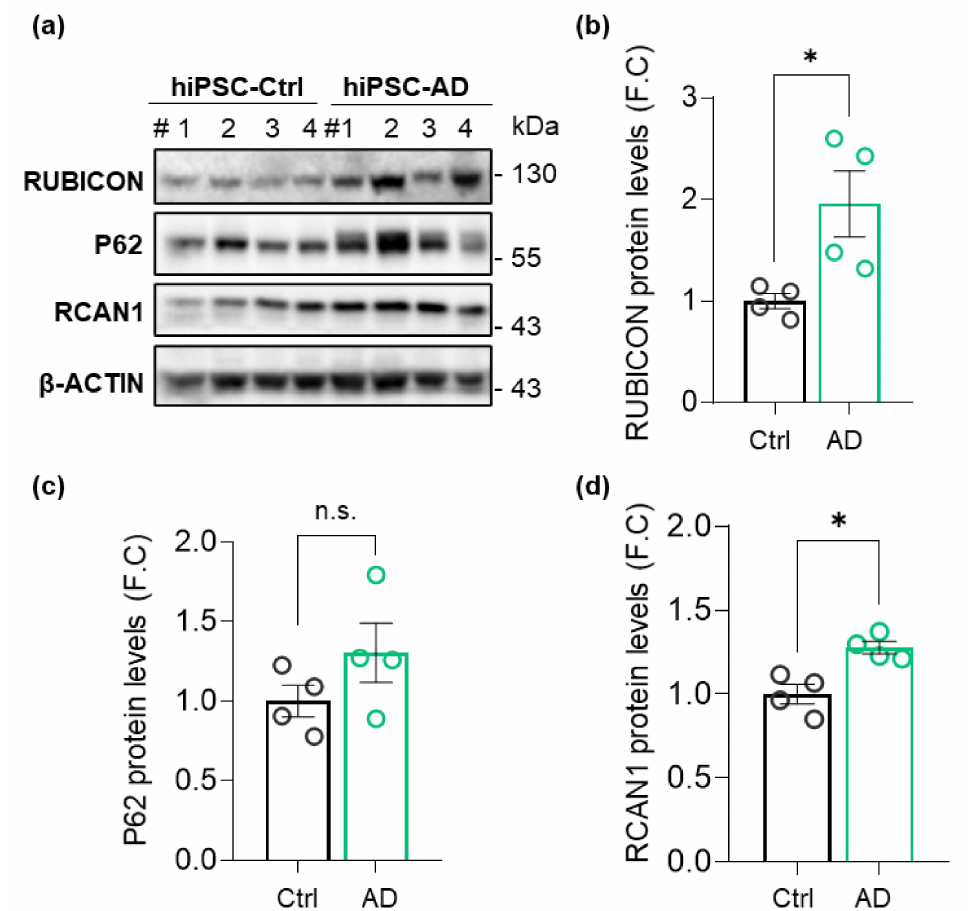
Figure 1. RUBICON protein levels are increased in human-induced pluripotent cells (hiPSCs) derived from an AD patient. ( a ) Total protein extracts were prepared from control (Ctrl) and AD hiPSCs. RUBICON, P62, RCAN1, and β -ACTIN levels were determined by Western blot, n = 4. Protein content was normalized with β -ACTIN. #, number of independent cell clones. ( b ) Densitometric analysis of normalized RUBICON, ( c ) P62, and ( d ). RCAN1 levels from total extracts. FC, fold change. Data are mean ± SEM ( n = 4). * p < 0.05 as determined by a Mann-Whitney t -test, n.s., no